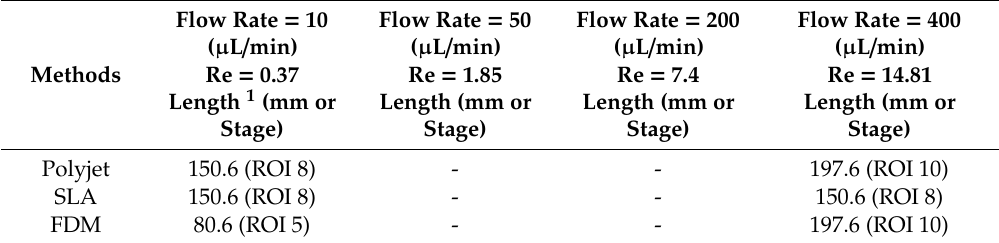
Table 2. Required length for each Y-shape serpentine micro-mixer fabricated by three methods where a relative intensity was reached, which can be considered complete